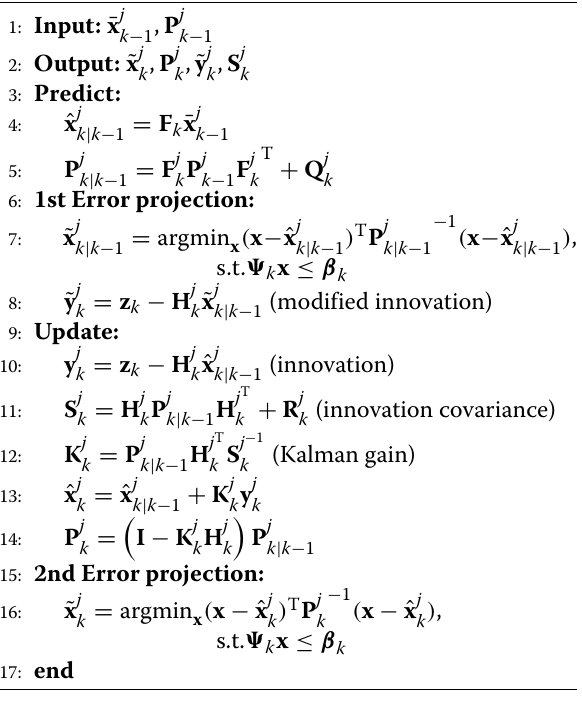
Algorithm 2 Modified Kalman filter in constrained